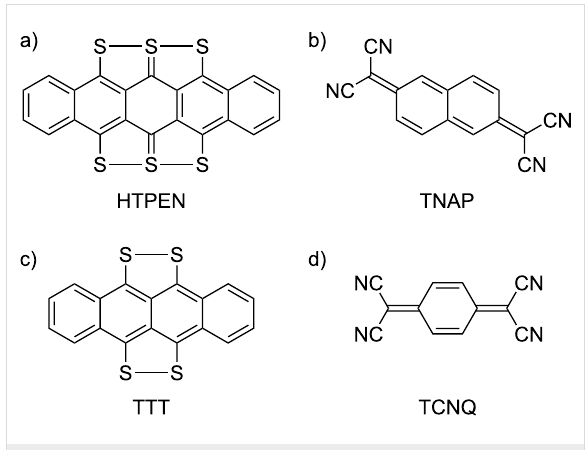
Figure 1: Chemical structures of (a) HTPEN, (b) TNAP, (c) TTT, and (d)